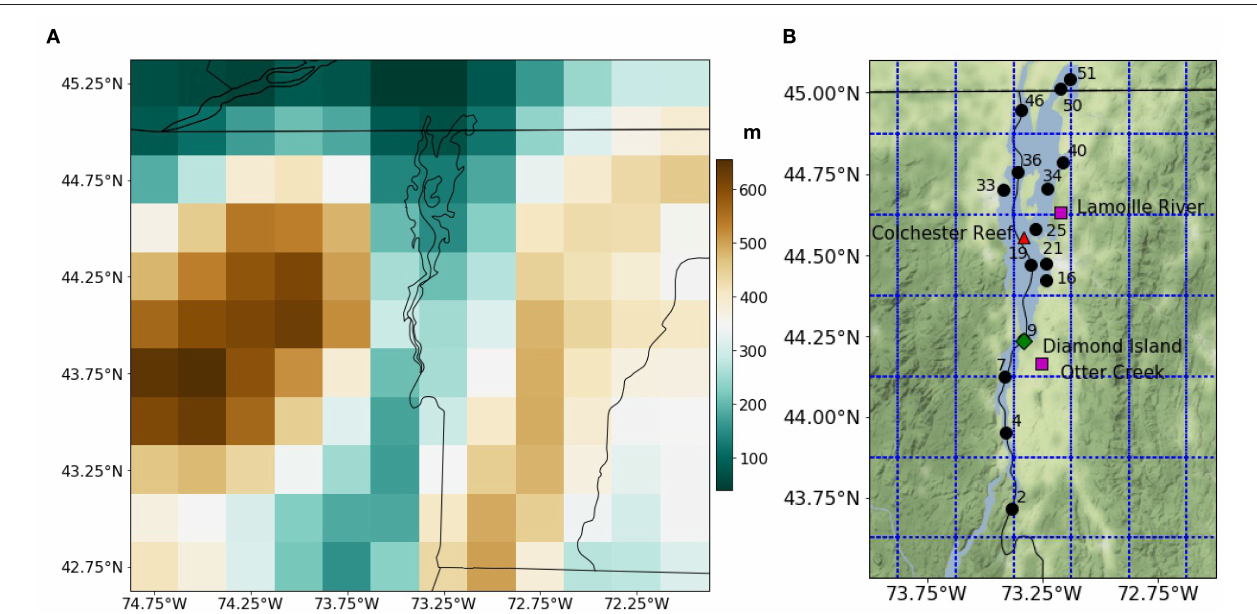
FIGURE 1 | (A) ERA5 (0.25 ◦ ) 2 grid for larger domain showing model grid mean topography and (B) Lake Champlain observation sites with ERA5 grid boxes superimposed. The green diamond and red triangle mark our main observation sites: Diamond Island and Colchester reef.